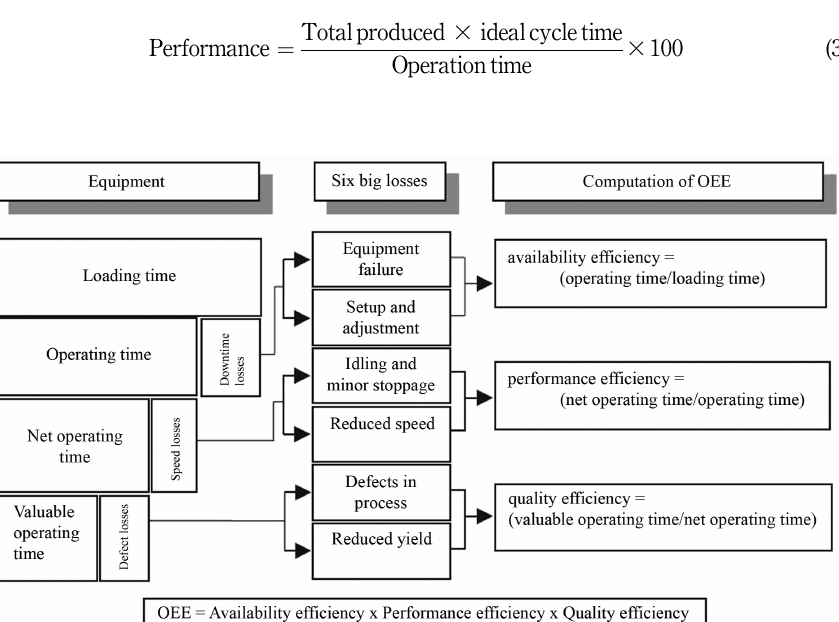
Figure 1. The OEE and its computation